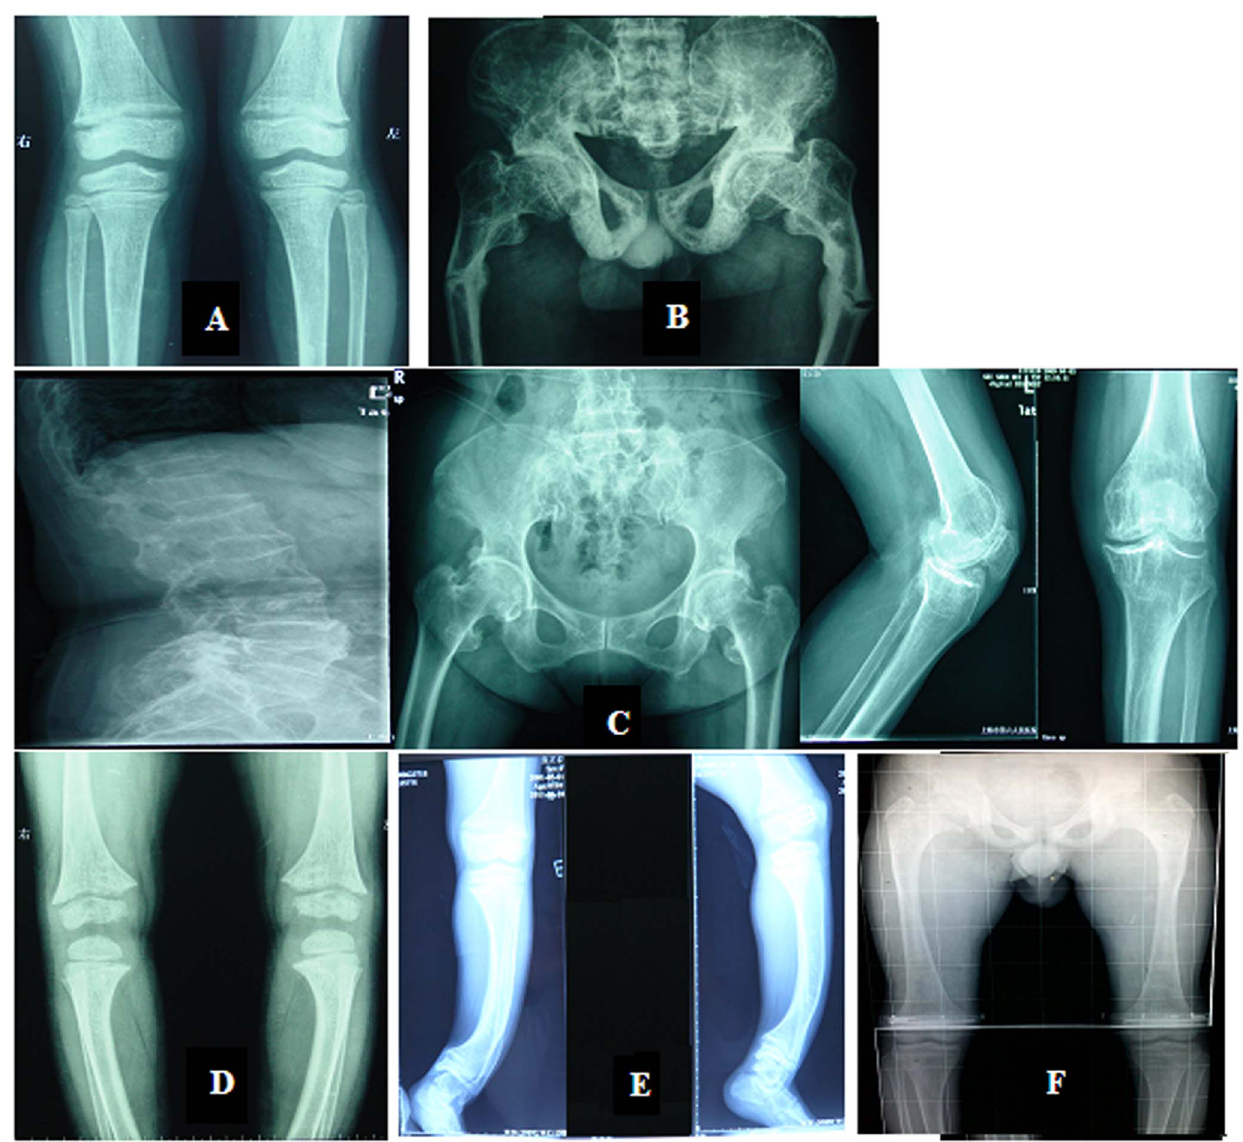
Figure 2. Radiology results for the patients. (A): A general decrease in bone density, widened metaphyses, bilateral femoral distal metaphysis epiphyseal line blurred, and similar features in the lower tibia are shown. (B): A high bone mineral density, genu varum deformities in the lower limbs, and a Looser Zone in the bilateral femoral shaft are shown. (C): A general decrease in the bone density of the vertebrae and pelvis, bilateral hip and knee joint degeneration, and multiple vertebral wedge changes are shown. (D): Widened metaphyses is shown. (E): A high bone mineral density and anterior bowing of the lower limbs are shown. (F): A general decrease in the bone density of the vertebrae and pelvis, an enlargement of the epiphyseal and metaphyseal portions of the under section of the femoral, a short and wide femoral neck, and a large capital femoral epiphyses are shown.